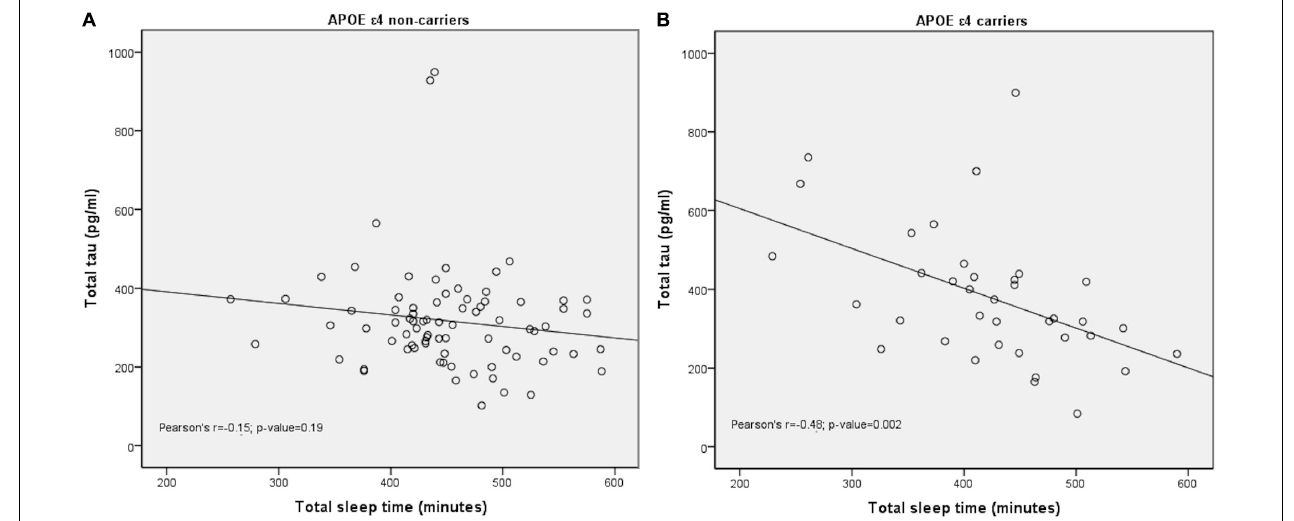
FIGURE 3 | Distribution of total sleep time and total-tau levels in CSF stratified by APOE . Scatter plot showing the distribution of values for total sleep time ( X -axis) and the tau levels ( Y -axis) stratified by APOE ε 4 status. While APOE ε 4 non-carriers showed no correlation with total sleep (A) , APOE ε 4 showed a negative correlation with total sleep (B)